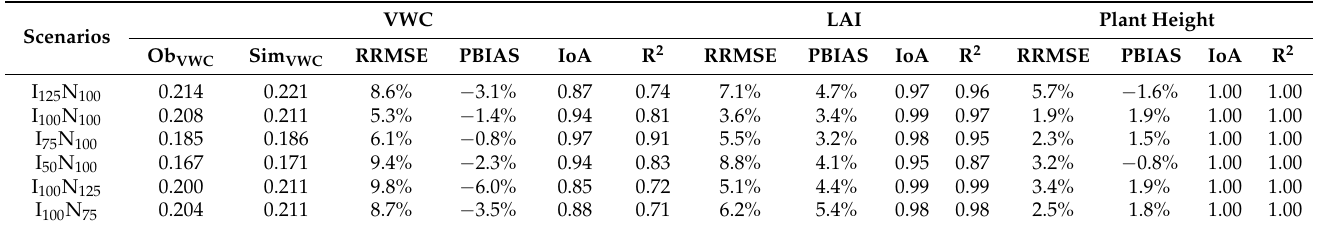
Table 4. Statistical criteria (i.e., RRMSE, PBIAS, IoA and R 2 ) results obtained by comparing the observed and simulated VWC (cm 3 /cm 3 ), LAI and plant height for each SDF